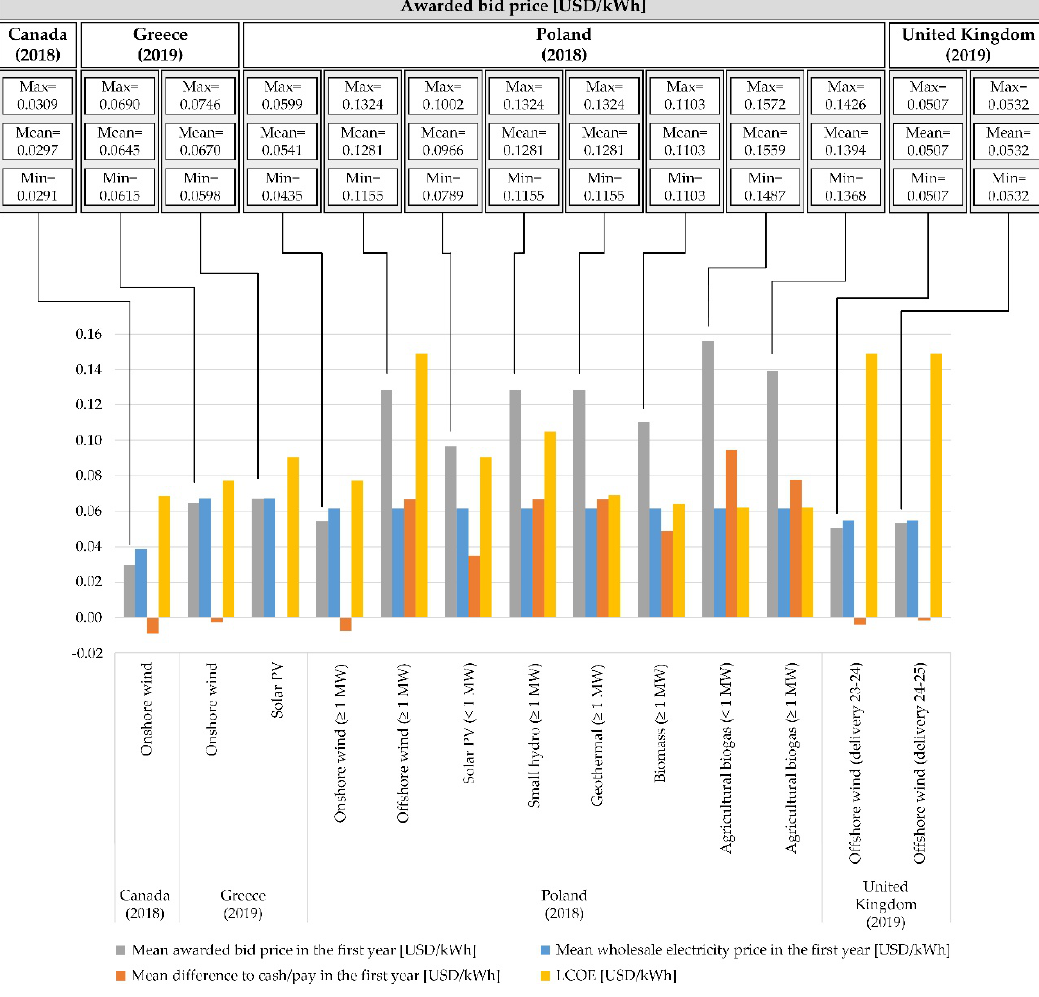
Figure 4. LCOE (yellow bars) versus mean awarded bid price under the CfD scheme (grey bars), mean wholesale electricity price (blue bars) and the resulting mean difference to receive or pay in the first year (orange bars) for the auctions of Canada, Greece, Poland and UK listed in Table 1. Source: self-elaboration.